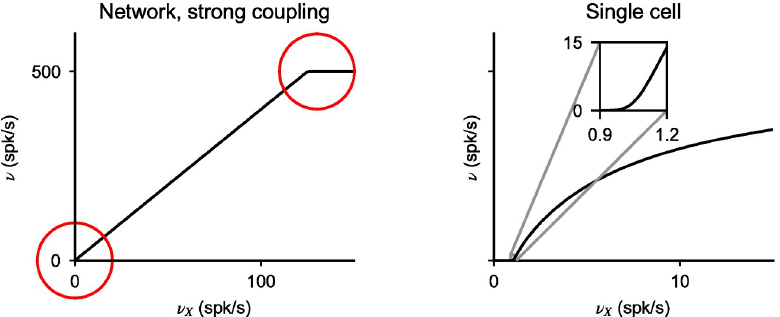
Fig 1. Network transfer function in the strong and weak coupling limits. Network response in strongly coupled networks (left) features linear regions separated by abrupt transitions (red circles). In the weak coupling limit, the network transfer function becomes identical to the single cell transfer function. It is supralinear at low inputs, but then becomes sublinear at high